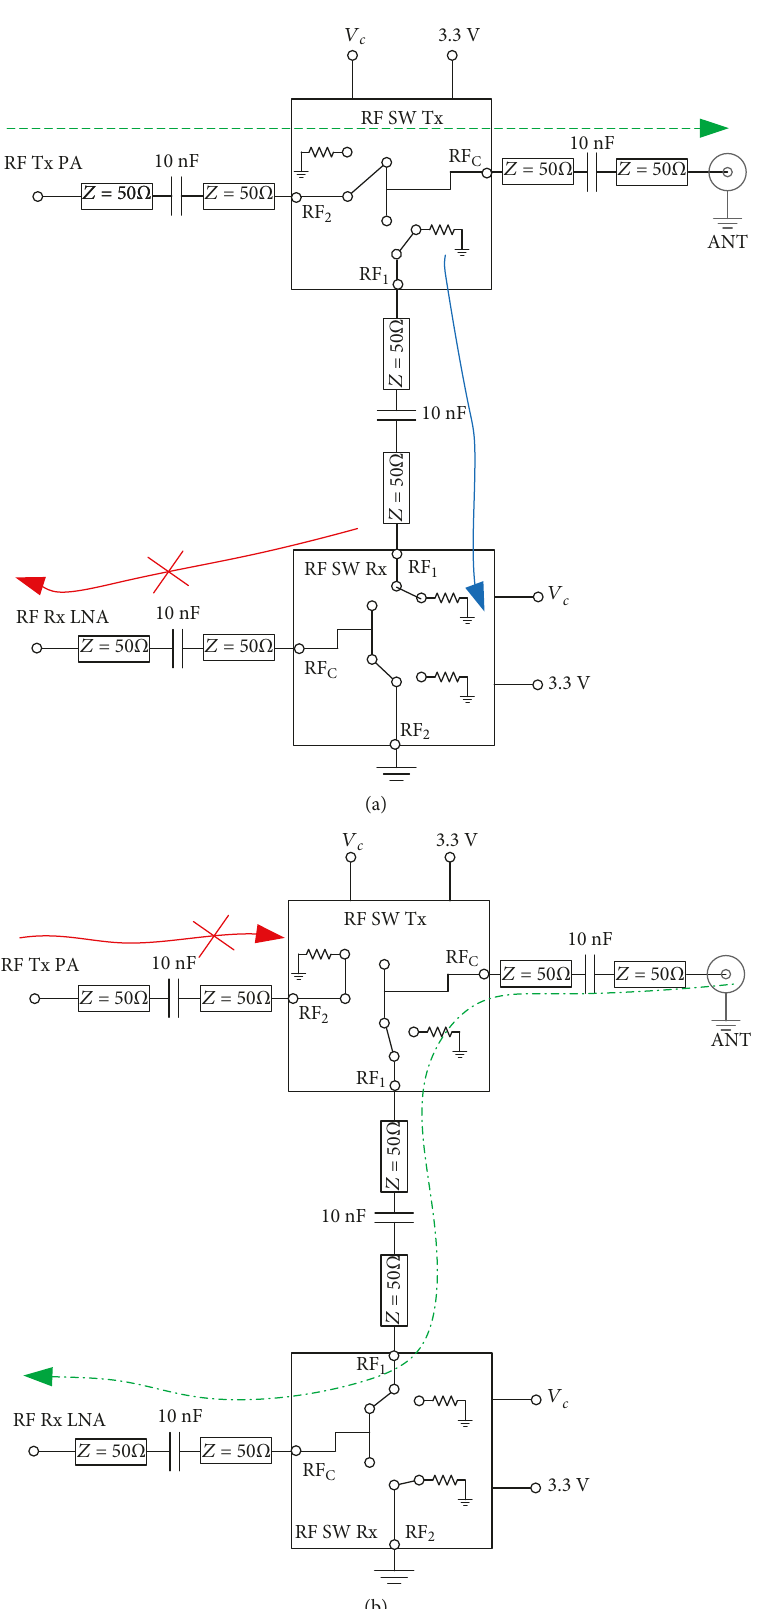
Figure 13: RF switches: (a) transmit mode with V